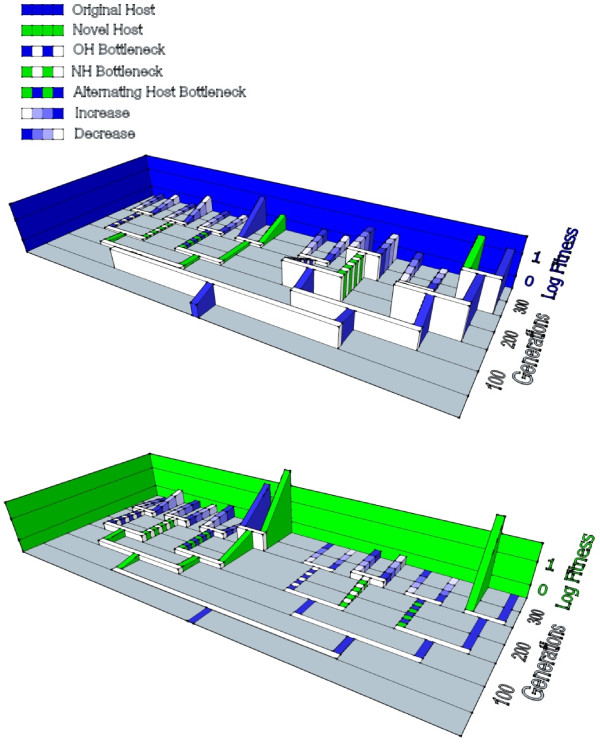
Phenotypic evolution through time, in light of the imposed experimental design. Values are mean log fitness of sequenced clones on (A) P. phaseolicola (PP) and on (B) P. pseudoalcaligenes (ERA). See Table 1 for numerical values and statistics